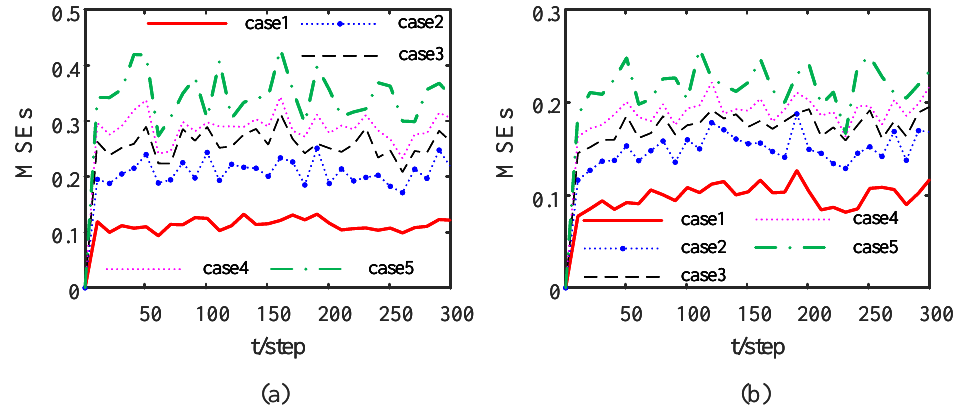
Figure 4. Comparison of MSEs of DOFCDs under different attack rates of the attack signals: ( a ) MSEs of the position filters; ( b ) MSEs of the velocity filters (authors’ own